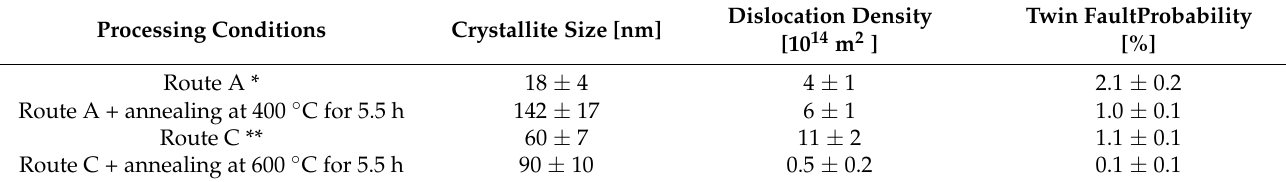
Table 3. Changes in the crystallite size and defect densities during annealing of Cu foams processed by dealloying under different conditions. Processing